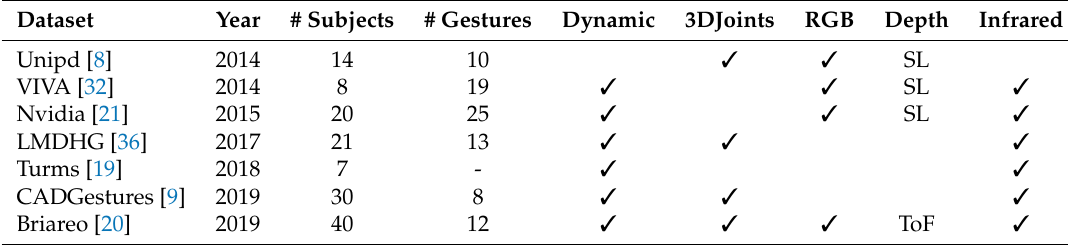
Table 1. A list of datasets commonly used for hand gesture classification task. We report the number (#) of subjects involved and the gestures, taking into consideration also the presence of dynamism and 3D hand joints (3DJoints). Furthermore, we include also the types of the collected data: RGB images, depth maps (from both Structured Light (SL) and Time-of-Flight (ToF) devices) and infrared